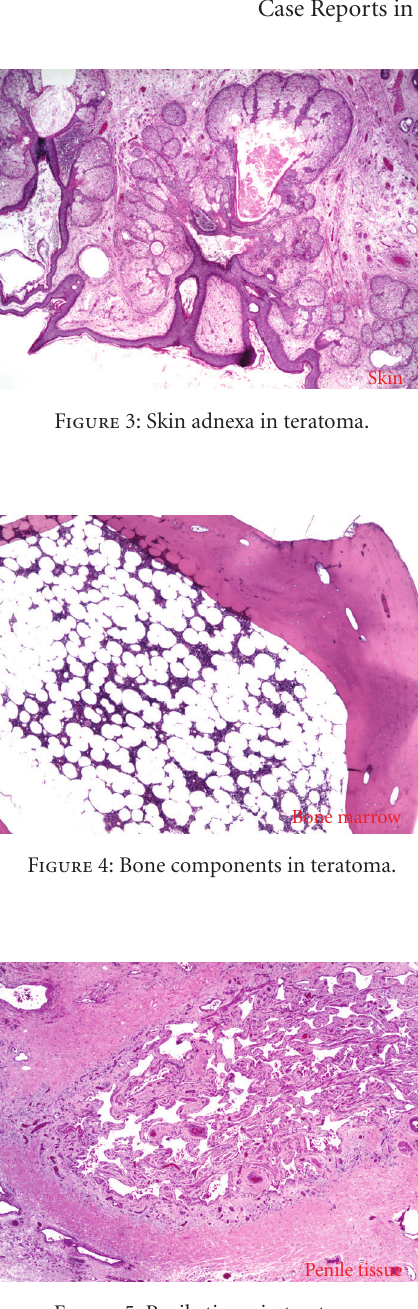
Figure 5: Penile tissue in